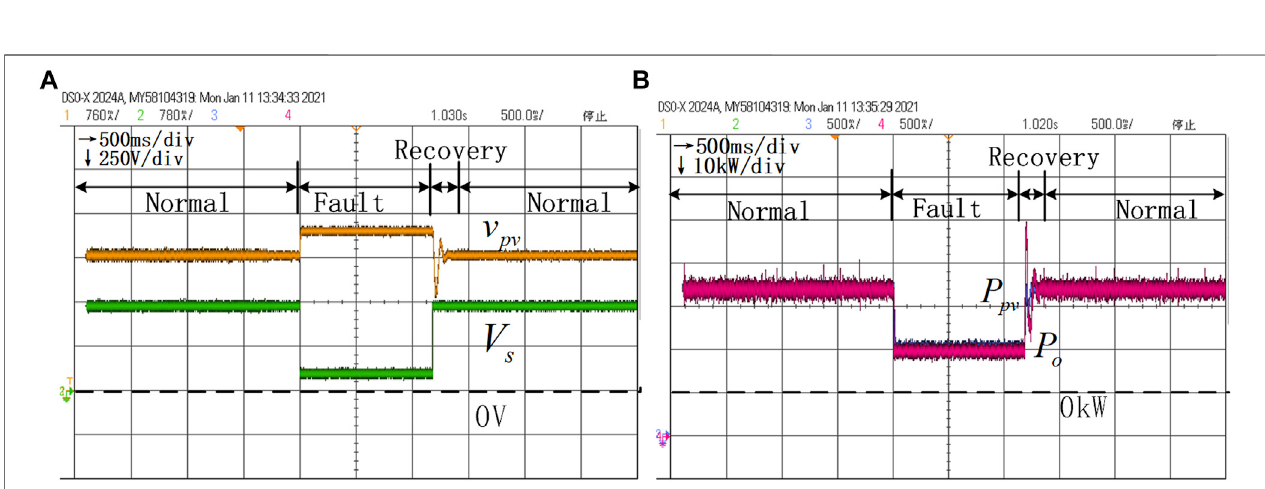
FIGURE11| HILresultsofvoltagedynamicsandpowerdynamicswithoutthevariableparametercontrolundertheconditions k p (cid:1) 0 . 6 , k i (cid:1) 5 , and C pv (cid:1) 1mF. (A) Voltage dynamics of v s and v pv . (B) Power dynamics of P o and P pv .